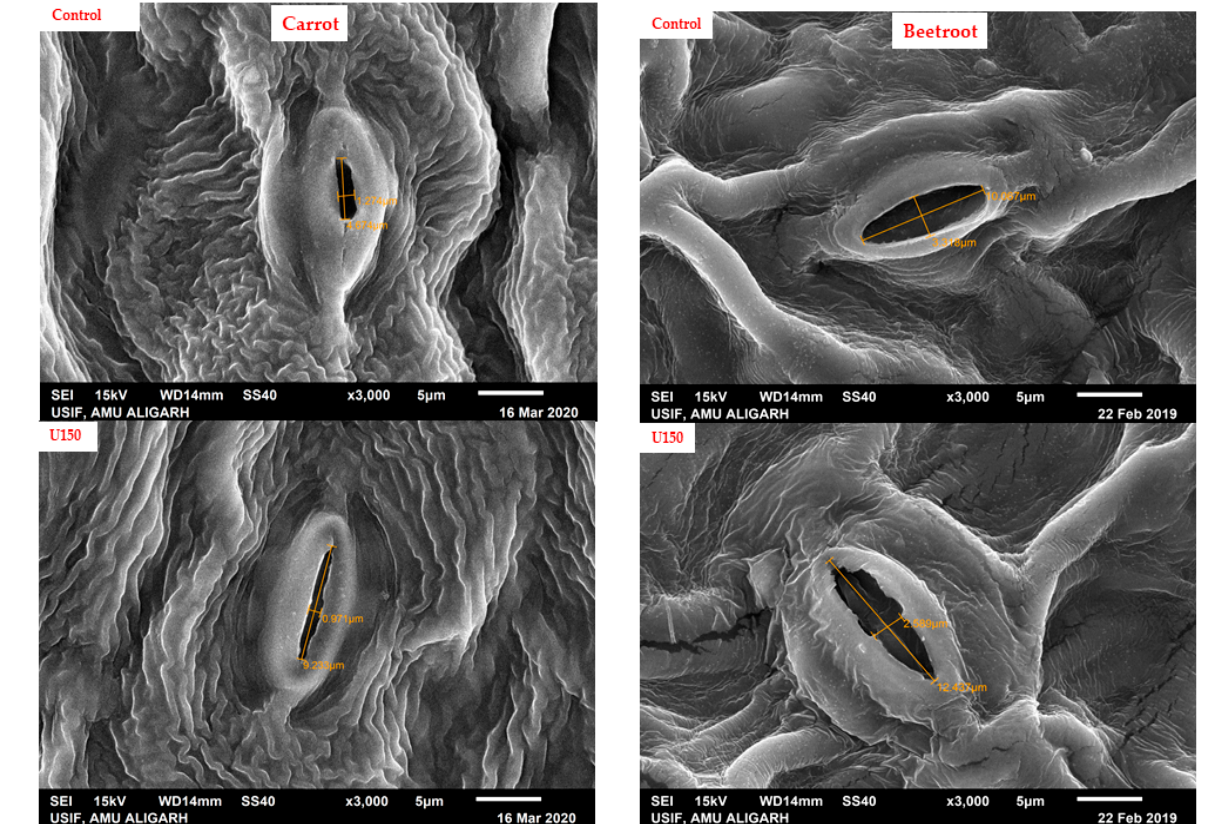
Figure 2. Impact of different N levels on the yield attributes of carrot and beetroot. Data from experiments are collected as the mean of three replicates ± standard error (SE). Different alphabets used indicate significant differences between treat- ments at p < 0.05, ( n = 3).